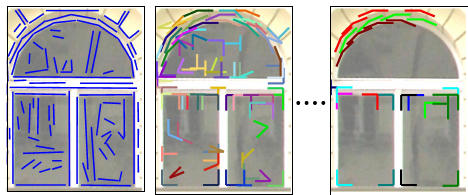
Figure 4: (Best viewed in colour) Detected aggregates from the learned set of relevant aggregate types for one given image sec- tion. Left: lines detected by FEX, A 1 . Middle: relevant line junctions, A 2 aggregates. Right: relevant aggregates from five lines, A 5 aggregates. As aggregates are possibly mutual overlap- ping, not all junctions are